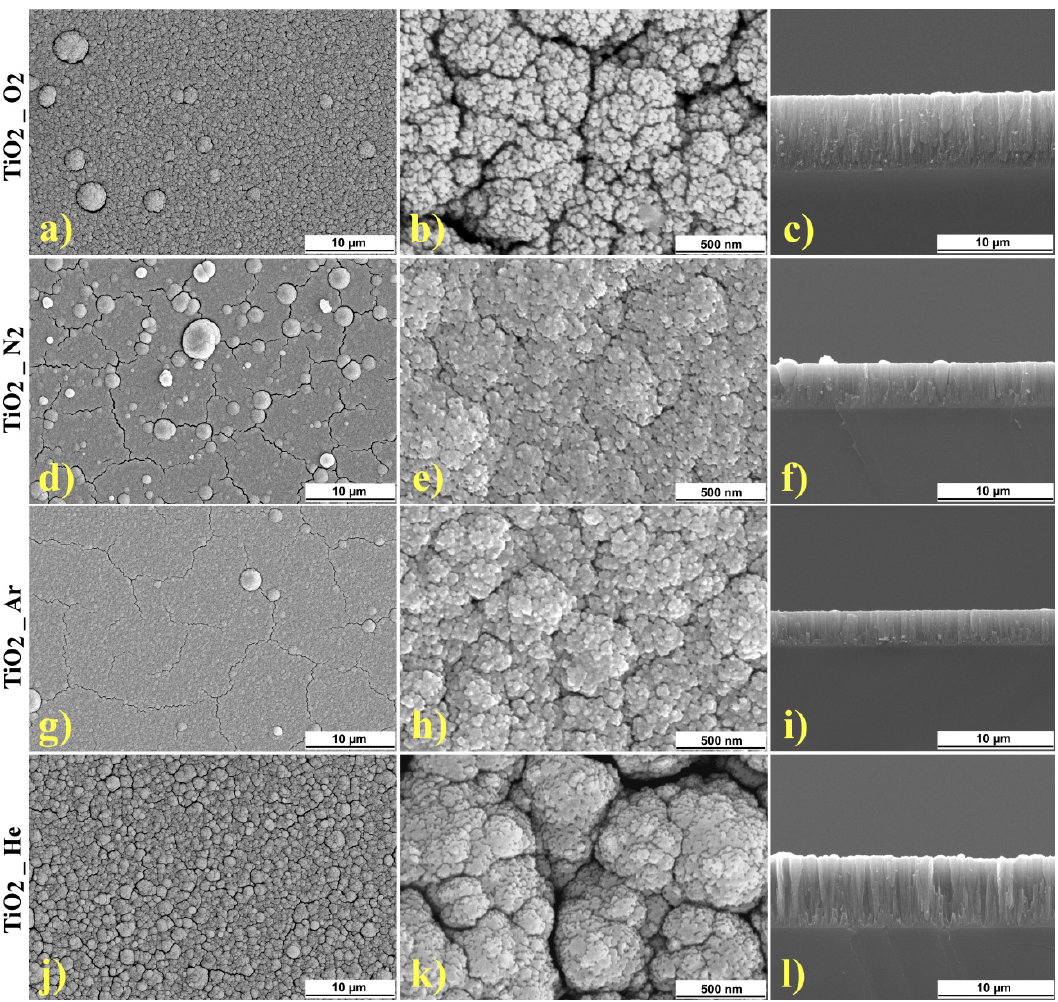
Figure 2. Typical top-view images of ( a , d , g , j ) low magnification, and ( b , e , h , k ) high-magnification, and ( c , f , i , l ) cross-section SEM micrographs of the thick nanostructured films deposited under various atmospheres (O 2 , N 2 , Ar, or He).